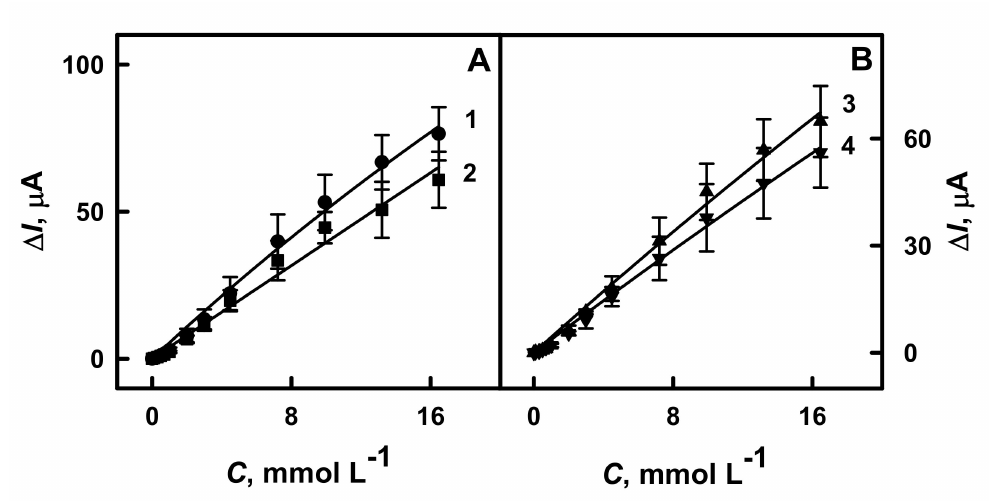
Figure 5. The linear detection range of biosensors based on GR electrodes modified by: ( A ) PANI-AuNPs (6 nm) -GOx/GOx (1 line) and PANI-GOx/GOx (2 line), ( B ) Ppy-AuNPs (6 nm) -GOx/GOx (3 line) and Ppy-GOx/GOx (4 line). Conditions: